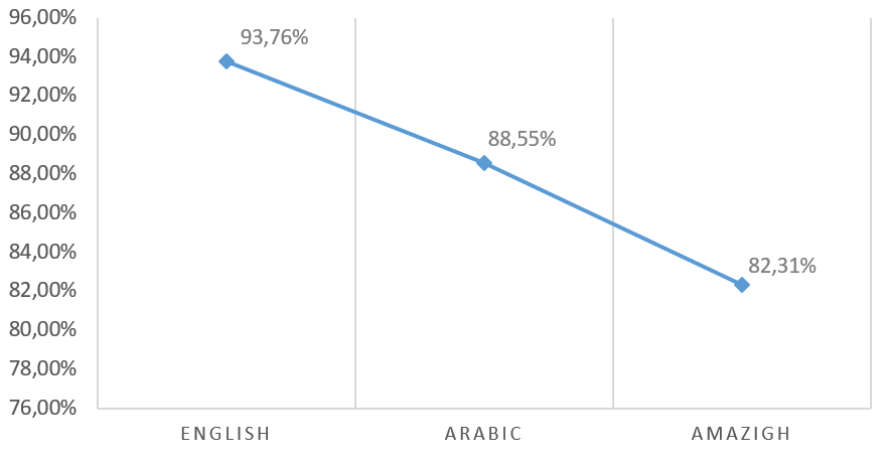
Figure 11. Achieved performance during test phase for each data